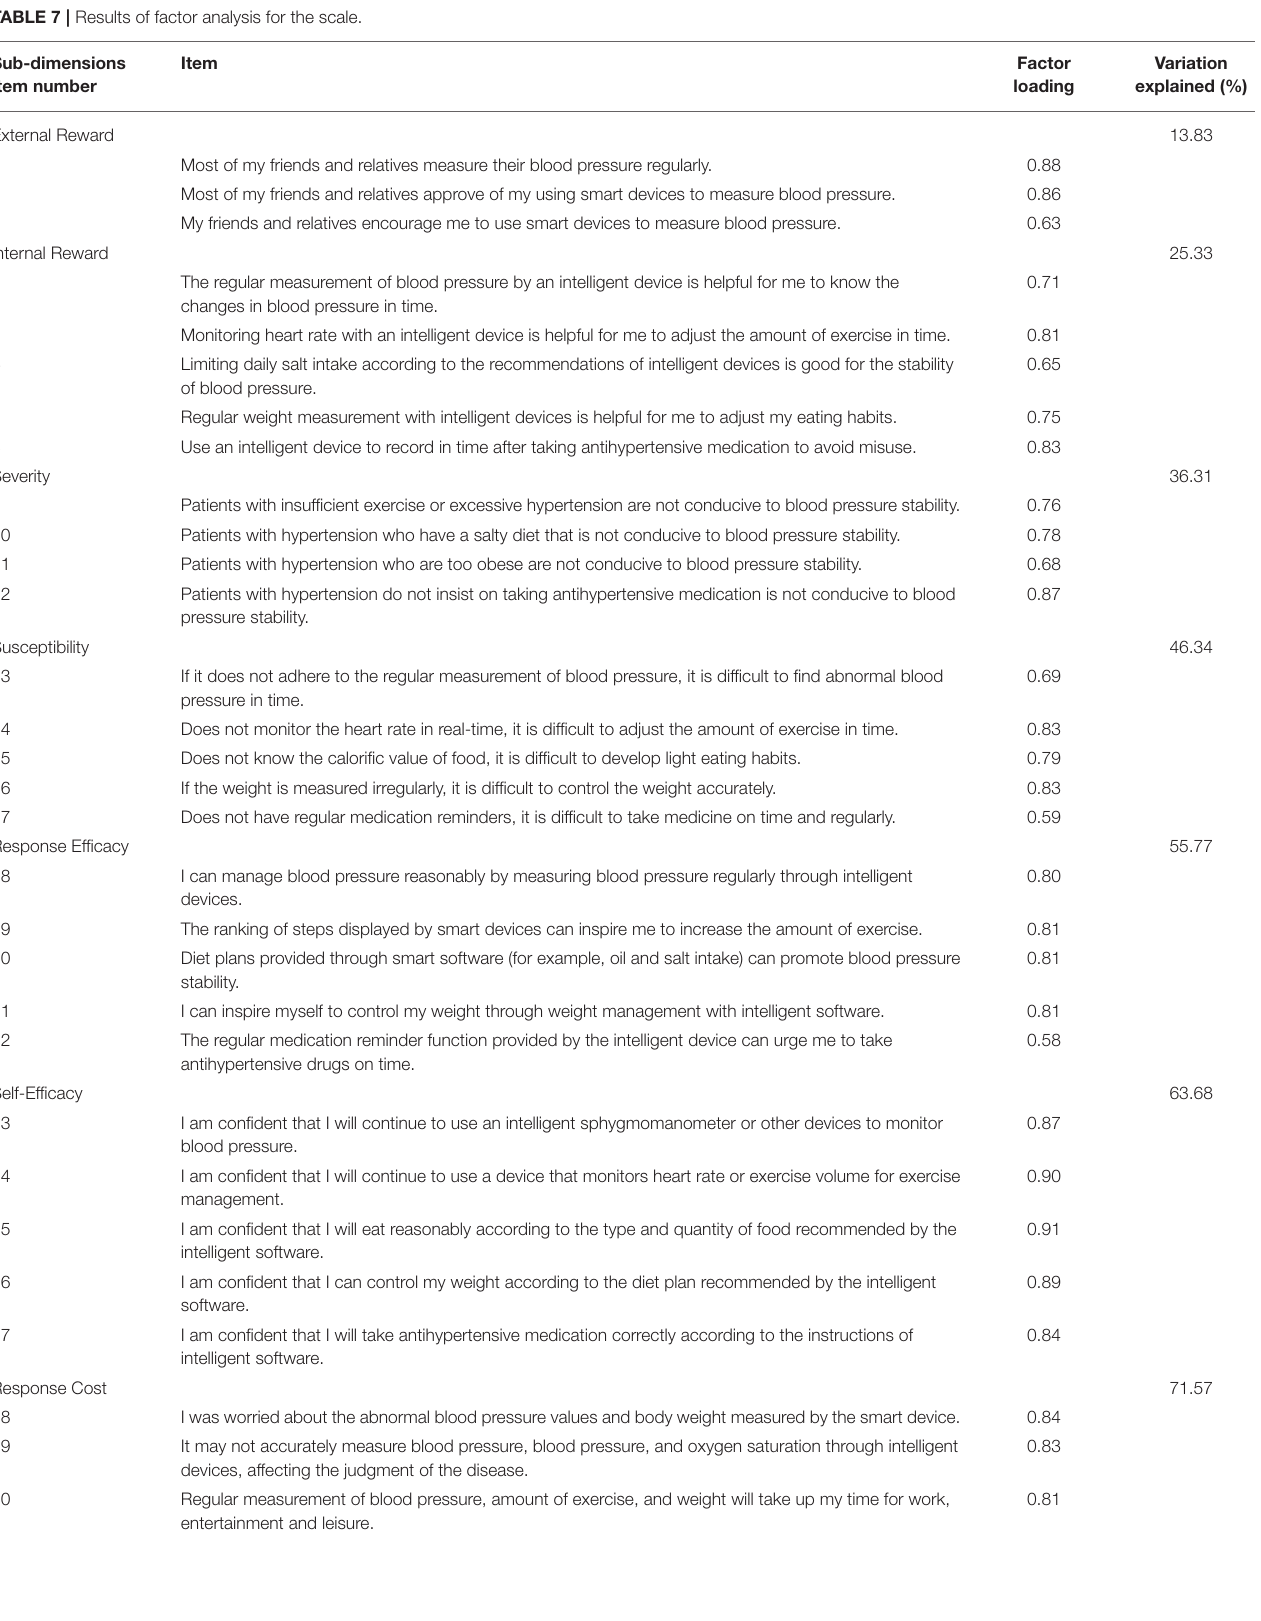
TABLE 7 | Results of factor analysis for the